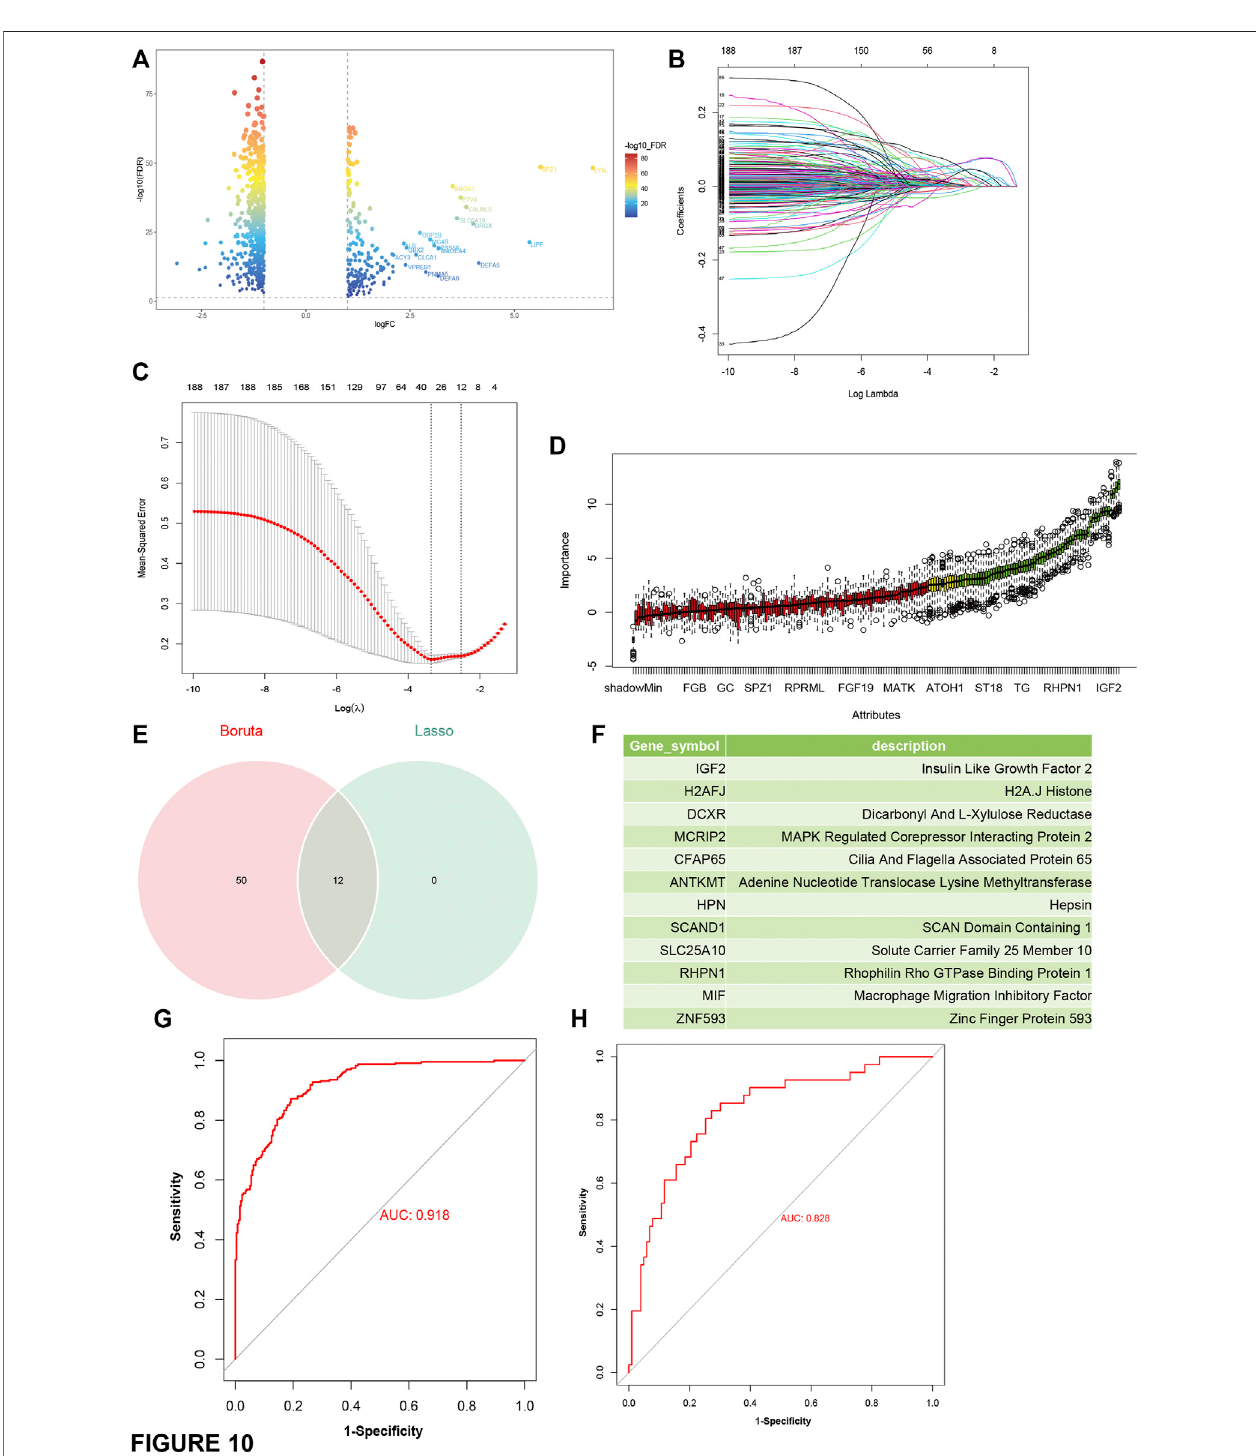
FIGURE 10 | Construction and evaluation of predictors based on the most representative genes of C1 and C2 subtype. (A) Volcano plot compares gene expressions between C1 and C2 and other subtypes. Genes with log2 (fold-change) beyond 1 with adjusted p -value (FDR) lower than 0.05 were considered as signi fi cantly upregulated in C1 and C2 subtype (B) LASSO regression analysis: coef fi cient values at varying levels of penalty. Each curve represents a gene. (C) Ten-fold cross-validation was used to calculate the best lambda, contributing to the minimum mean cross-validated error (cvm). (D) Boruta analysis: Importance plot of the genes. Green boxes represent important features (retained), and red boxes represent unimportant features (declined). (E) Venn diagram identifying the most critical C1 andC2speci fi cvariablesthatweresharedbytheLASSOandBorutamethods. (F) listofthemostrepresentativegenesofC1andC2. (G,H) ROCcurvesofpredictorsfor distinguishing C1 and C2 subtype and other subtypes in the training cohort (TCGA) (G) and the test cohort (ICGC) (H) .